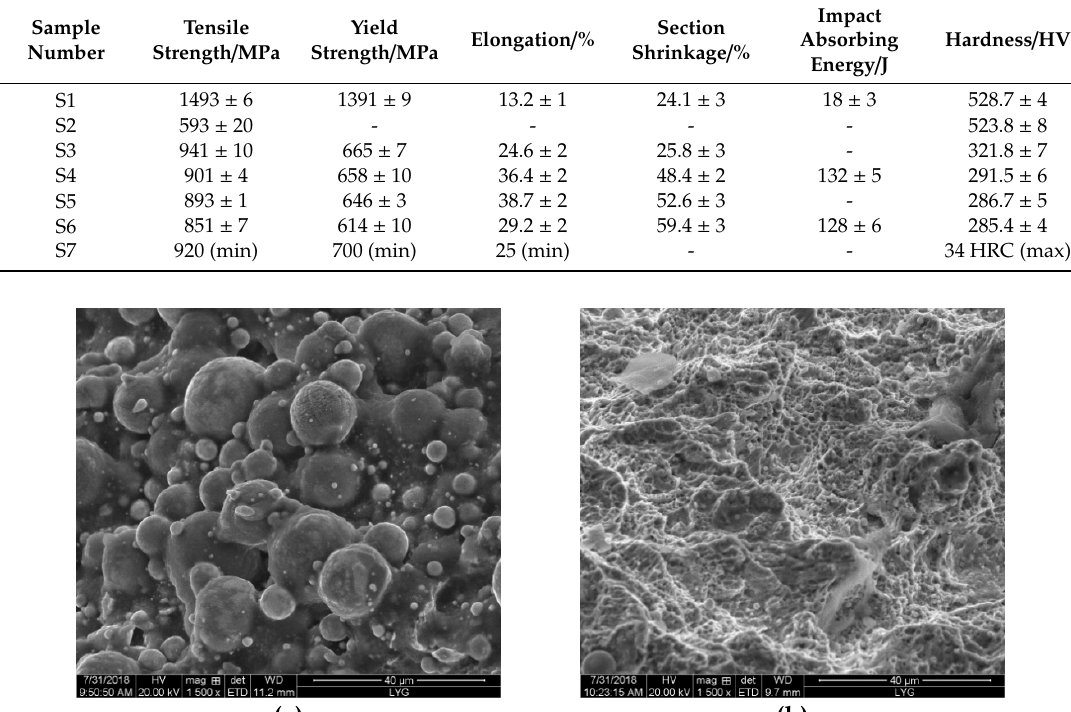
Figure 5. The fracture morphology of the S4 specimen ( a ) tensile fracture; ( b ) impact fracture.